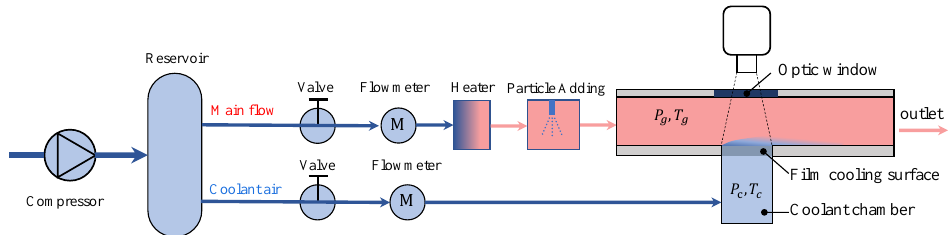
Figure 1. Schematic of the experiment apparatus for particle deposition